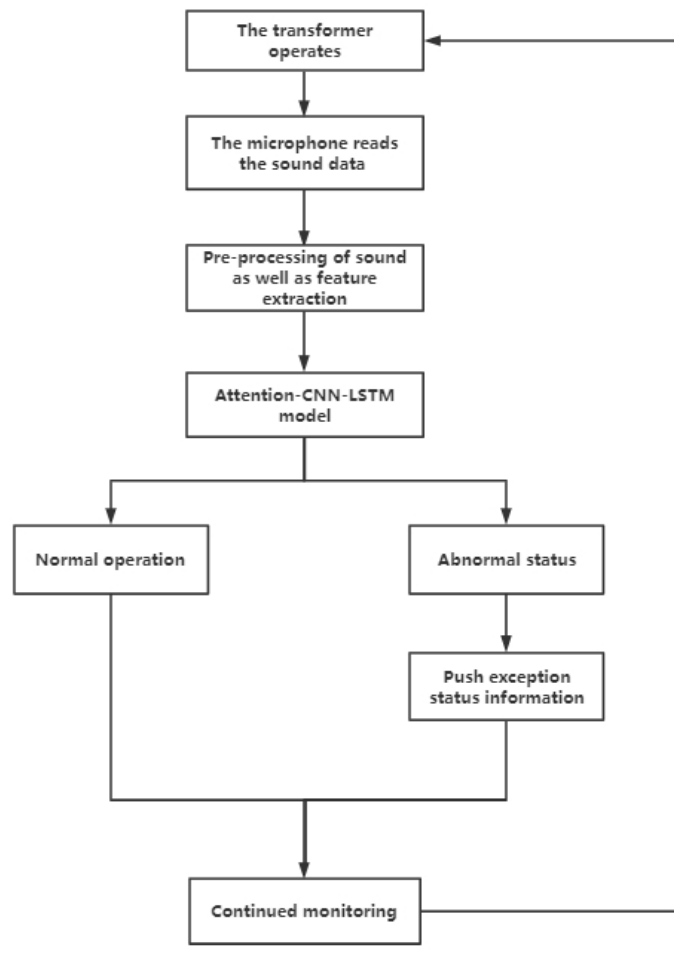
Figure 11. The transformer monitors the overall flow chart in real time. The specific steps for detection are as